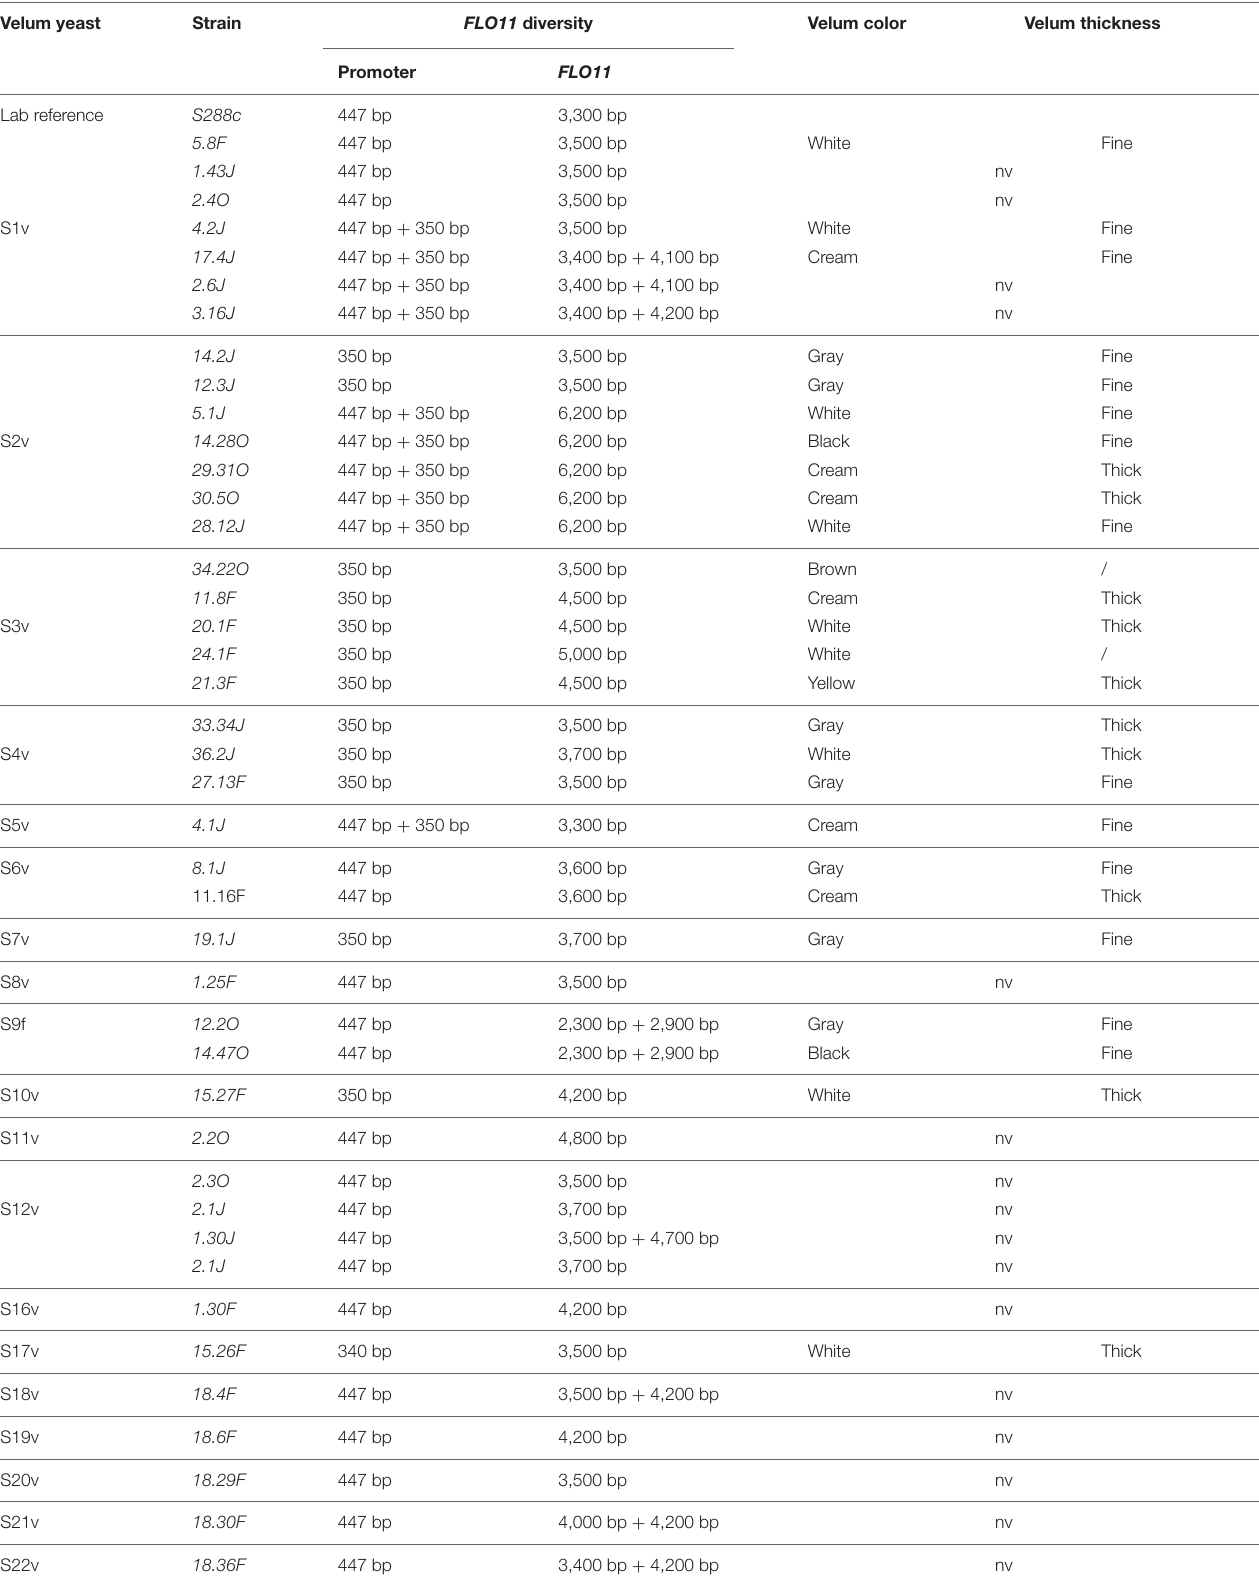
TABLE 6 | FLO11 promoter size and ORF length variations, velum color and thickness of various flor strains [55 clones belonging to 38 genotypes (S1v to S38v)]. Velum yeast Strain FLO11